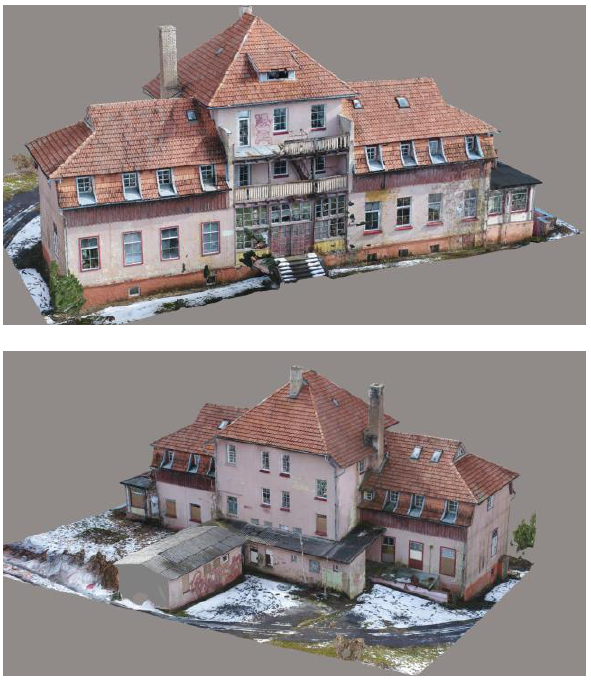
Figure 5. 3D models from surveyers measurements In the data processing work stage 3D images are created, which are used to generate orthophoto images of all facades. This images were used for 2D drafting creation for architectural purposes (Fig. 6-9 (a)). The architects, as mentioned in the article, prepares building reconstruction 2D draftings (Fig. 6-9 (b)). Changes, which occured in surveyers 2D drafting after the architect's work are analysed in this article.